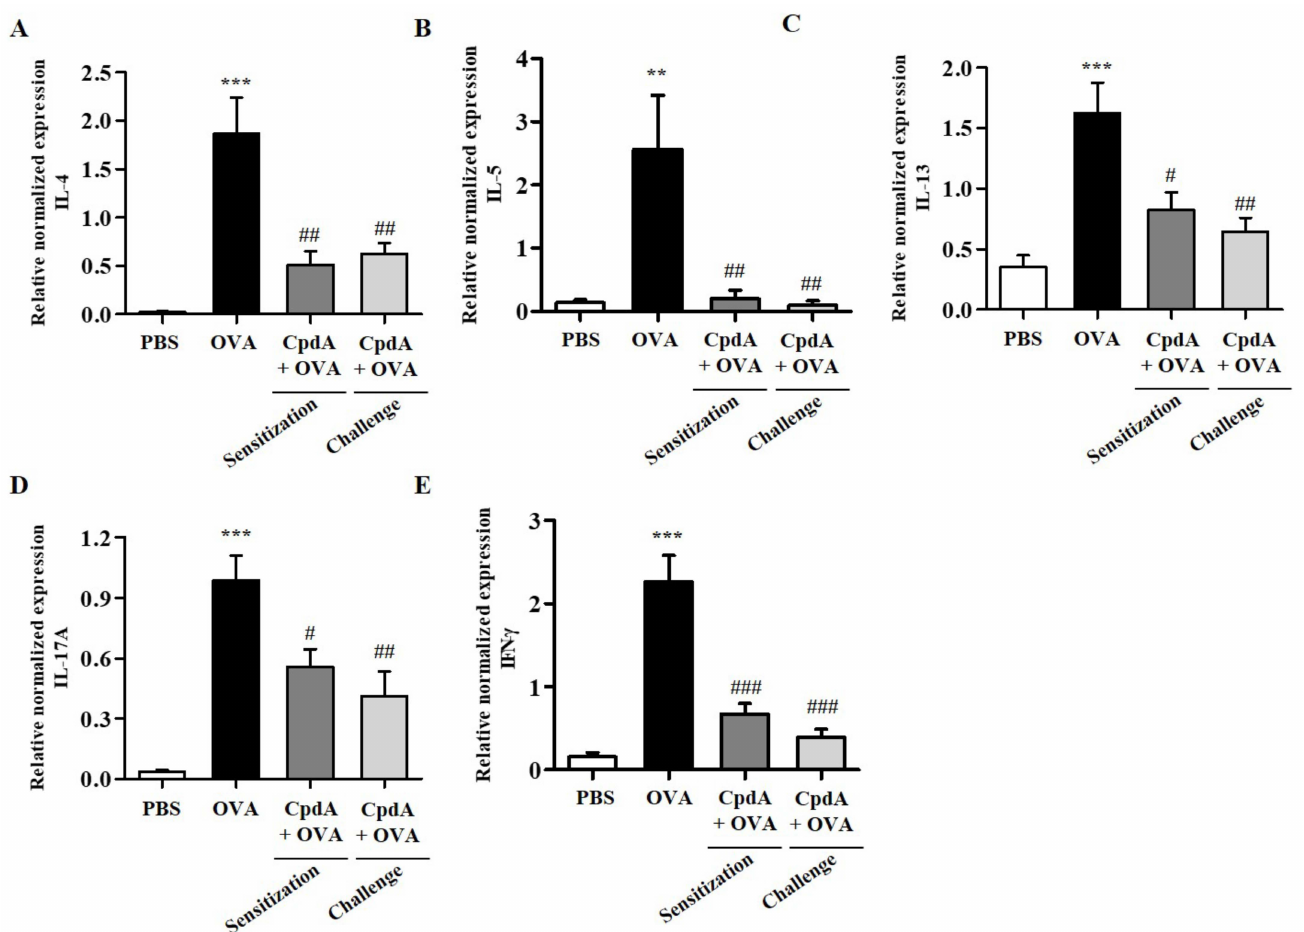
Figure 4. Effect of compound A on expression levels of T H 2, T H 17, and T H 1 cytokines in the BALF of OVA-induced asthma in FFA4-WT mice. Analysis of mRNA expression of T H 2 (IL-4, IL-5, and IL-13), T H 17 (IL-17A), and T H 1 (IFN- γ ) cytokines in BALF of OVA-induced and compound A-treated FFA4- WT mice. Relative mRNA levels of cytokines were quantified as ratios to GAPDH transcript levels. ( A ) IL-4, ( B ) IL-5, ( C ) IL-13, ( D ) IL-17A, and ( E ) IFN- γ . The results are presented as mean ± SEM ( n = 5). ** p < 0.01, *** p < 0.001 vs. the PBS-treated group, # p < 0.05, ## p < 0.01, ### p < 0.001 vs. the OVA-treated